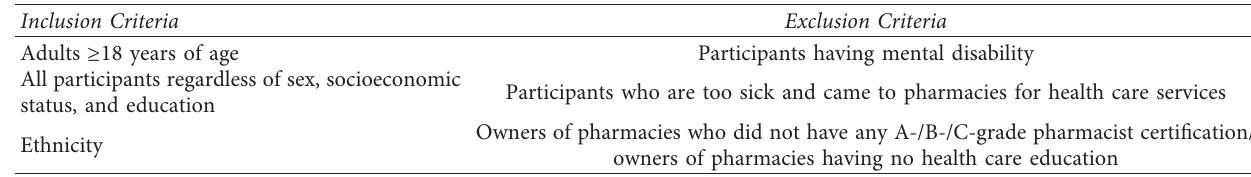
Table 6: Inclusion and exclusion criteria for the selection of the